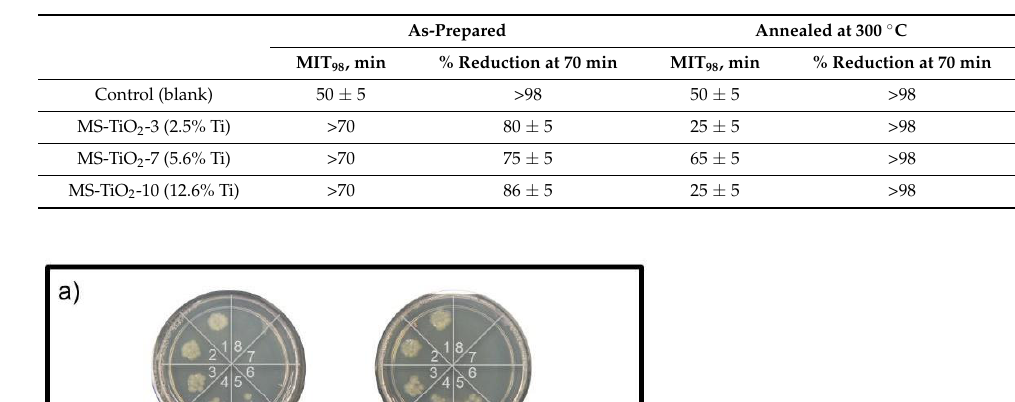
Table 2. The antimicrobial activities of the as-prepared and annealed MS-TiO 2 nanocomposites under 365 nm UV light for treating a 10 4 CFU/mL E. coli suspension.